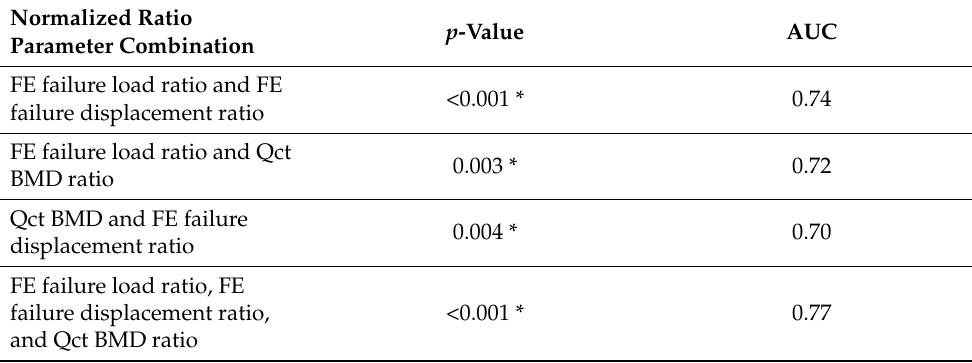
Table 4. Area under the curve (AUC) of different finite element (FE) and bone mineral density (BMD) ratio parameter combinations for identifying incidentally fractured